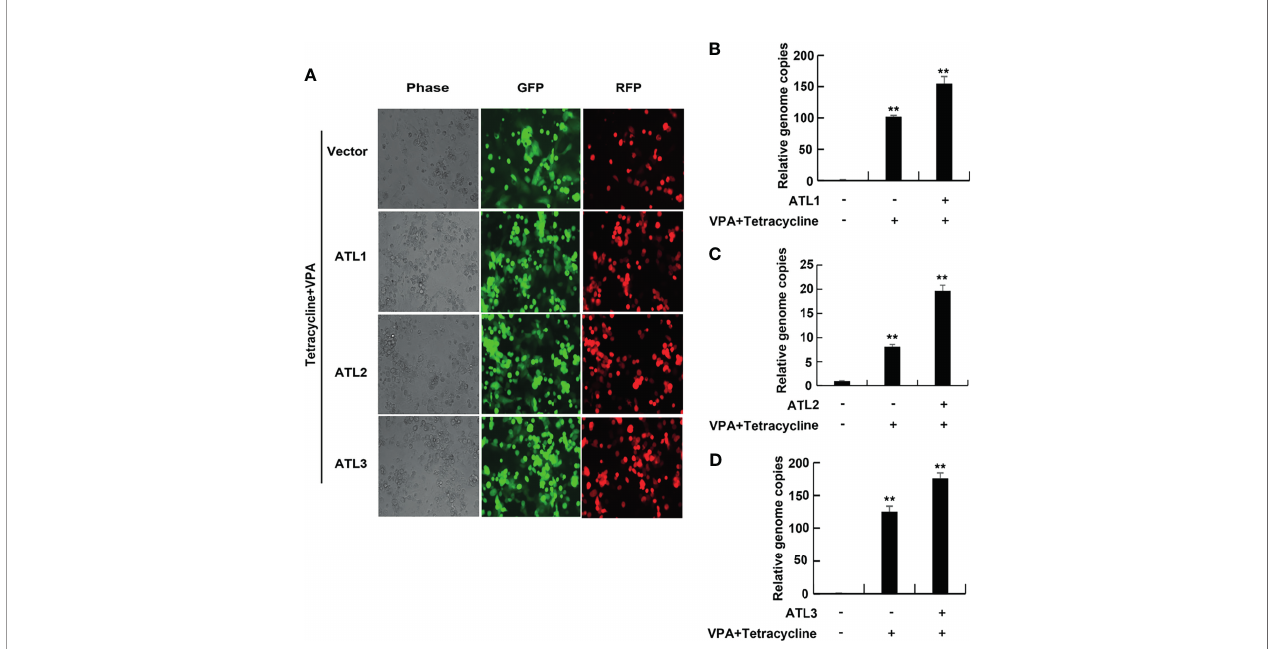
FIGURE 2 | ATLs overexpression promotes VPA induced KSHV lytic reactivation and virus particle production in iSLK.rKSHV.219 cells. iSLK.rKSHV.219 cells were transfected with vector, ATL1, ATL2 or ATL3 respectively followed by treatment with tetracycline plus valproate (VPA) for 48 hours to induce KSHV lytic reactivation. (A) The cells were photographed for GFP and RFP fl uorescence. (B-D) Viral DNA in the media was quanti fi ed using qPCR, with normalization to an added plasmid FAM105B using the DD CT method. Data are presented as means of three technical replicates (n=3, group values are indicated by mean ± SEM; **